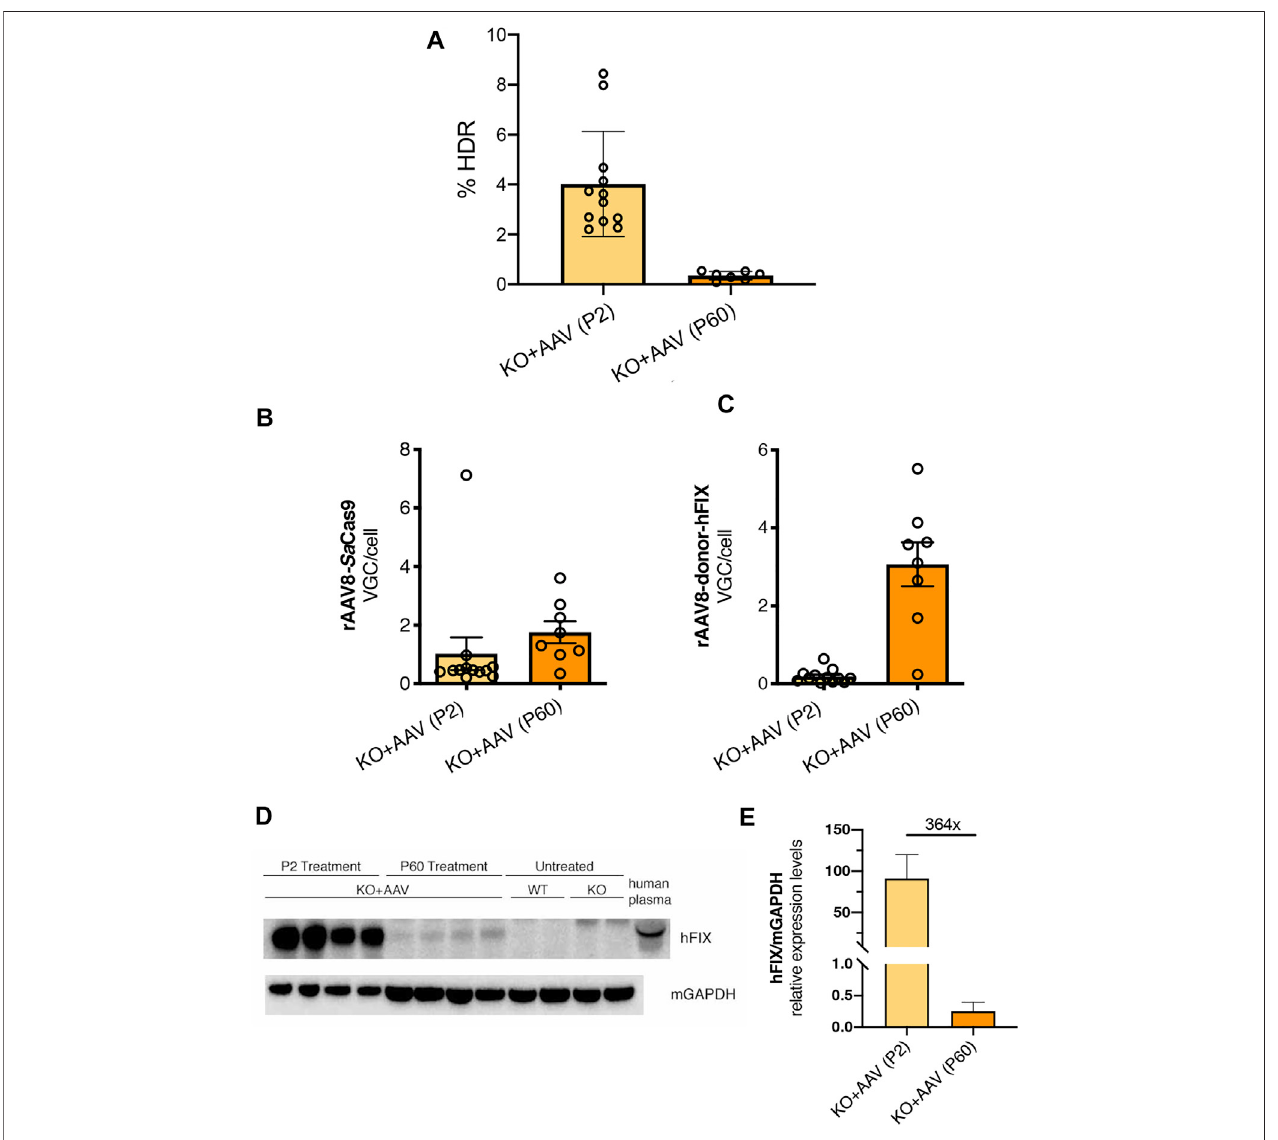
FIGURE6| Evaluatingthegenometargetingrate,thepresenceofviralgenomecopiesandhFIXproteininhepatocytes. (A) Genometargetingratewasevaluatedin neonatalandadult-treatedmicebyddPCRoflivergenomicDNA(from Figures2 , 5 ); (B,C) rAAV8-SaCas9andrAAV8-donor-hFIXviralgenomecopiesanalysisfromFIX KOmicetreatedatP2andP60(from Figures2 , 5 ); (D) WesternblotanalysisofhFIXproteininliverextracts.MicetreatedatP2andP60,togetherwithuntreatedWTand KO were analyzed. Human plasma was used as a positive control; (E) Western blot was quanti fi ed and normalized with housekeeping GAPDH protein.